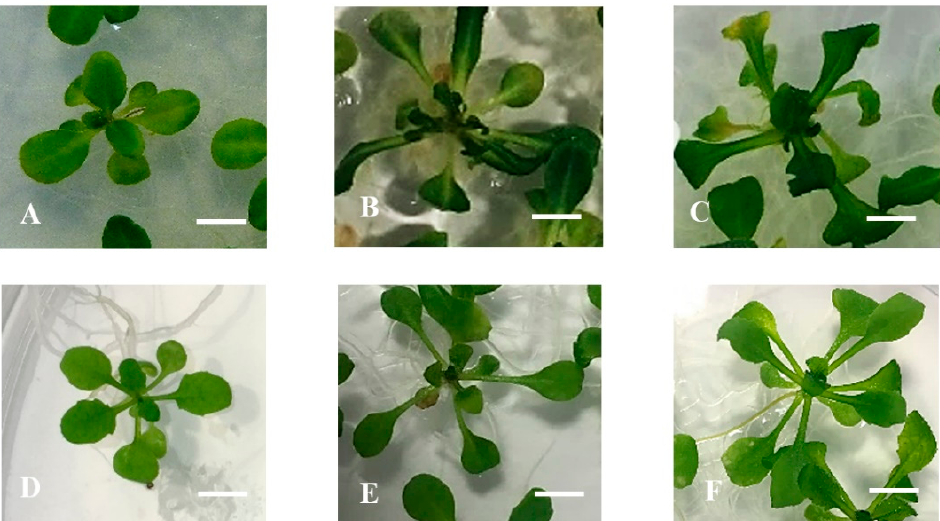
Figure 7. Phenotypic appearance of Arabidopsis thaliana Ler, Col-0, ref3-1, and ref3-3 seedlings after PIP treatment on 0.7% ( w/v ) Micro-agar (control). ( A – C ) Ler seedlings; ( A ) Cultured on Micro-agar (Control), ( B ) Cultured on 100 uM PIP, ( C ) ref3-1 seedlings, ( D – F ) Col-0 seedlings: Cultured on Micro-agar (Control), ( B ) Cultured on 100 uM PIP, and ( C ) ref3-3 seedlings. Bar = 3 mm.